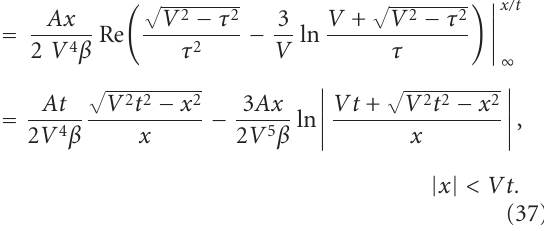
Table 2: Relevant numerical values between dynamic stress inten- sity factor K 1 ( t ) and time t